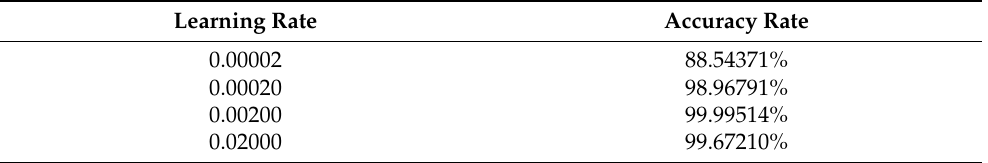
Table 2. Relationship between learning rate and accuracy.